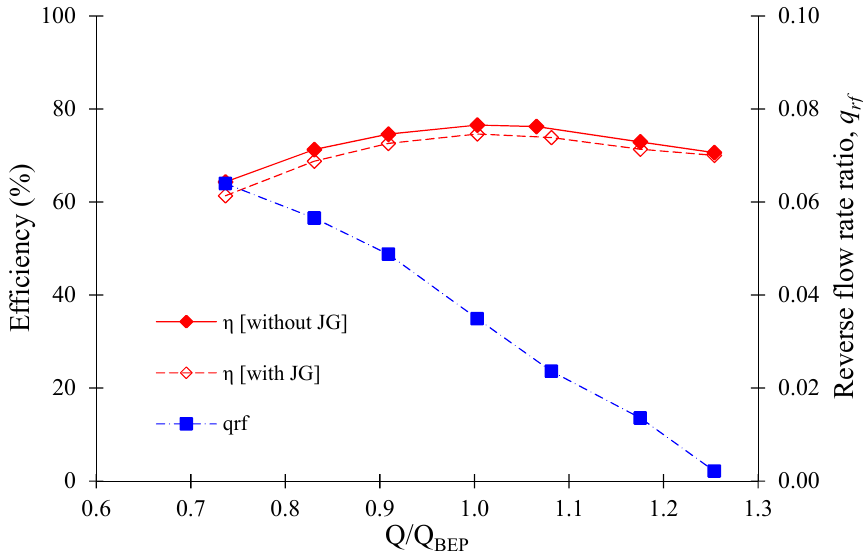
Figure 22. Performance curves of SCP model with reverse flow ratio.